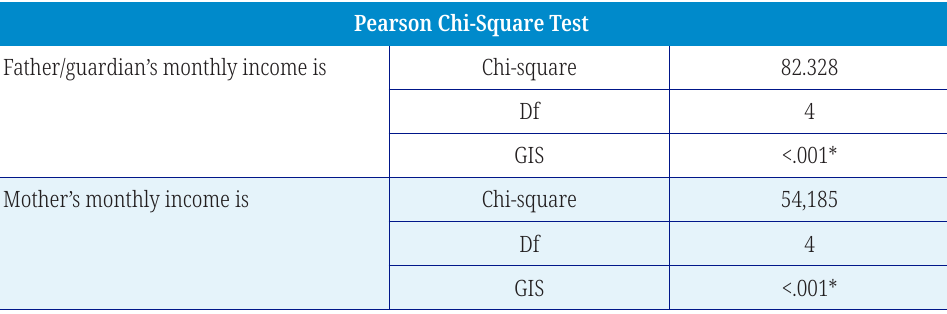
Table 8. Pearson chi-square test: economic status of parents of public/private university